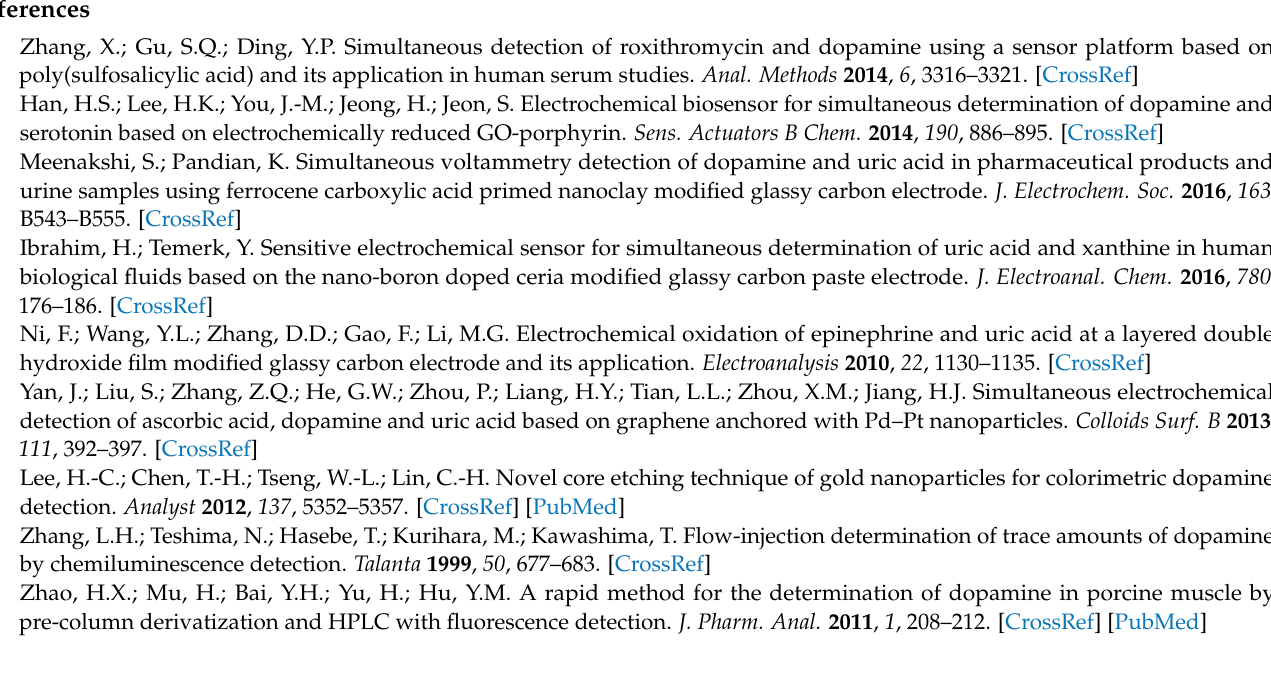
reduction of GO to rGO. Figure S2: Performance comparison of DPV curves on Ti 3 C 2 T x /rGO and Au/rGO electrode with 10 µ M DA in PBS and the corresponding current values. Figure S3: The anti-interference of our electrode in the presence of 100 µ M glucose, 100 µ M ascorbic acid, 100 µ M H 2 O 2 and 10 µ M isoniazid with PBS containing 3 µ M DA and 3 µ M UA. Table S1: The fitting parameters of EIS for GCE, Ti 3 C 2 T x and Ti 3 C 2 T x /rGO